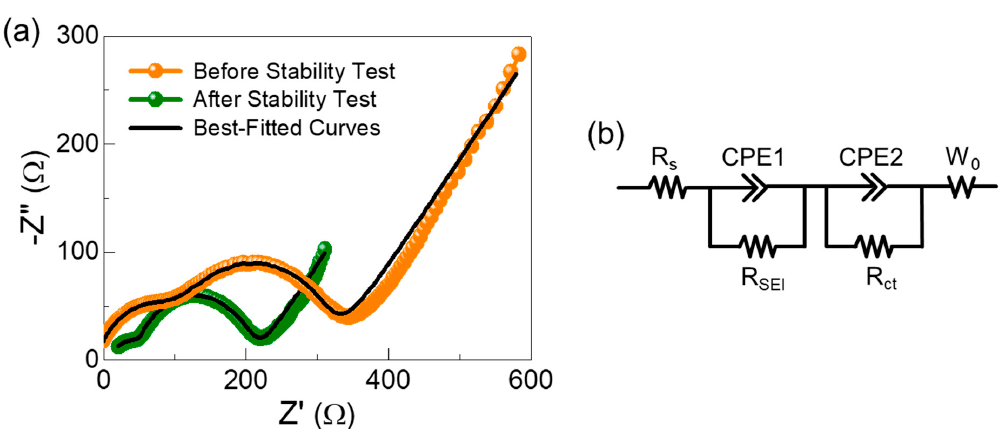
Figure 6. Charge-transfer characteristics of the C-Si nanocomposites: ( a ) Nyquist plots before and after the cyclic stability test and ( b ) equivalent circuit of the SIB device composed of the C-Si nanocomposites as an anodic material.